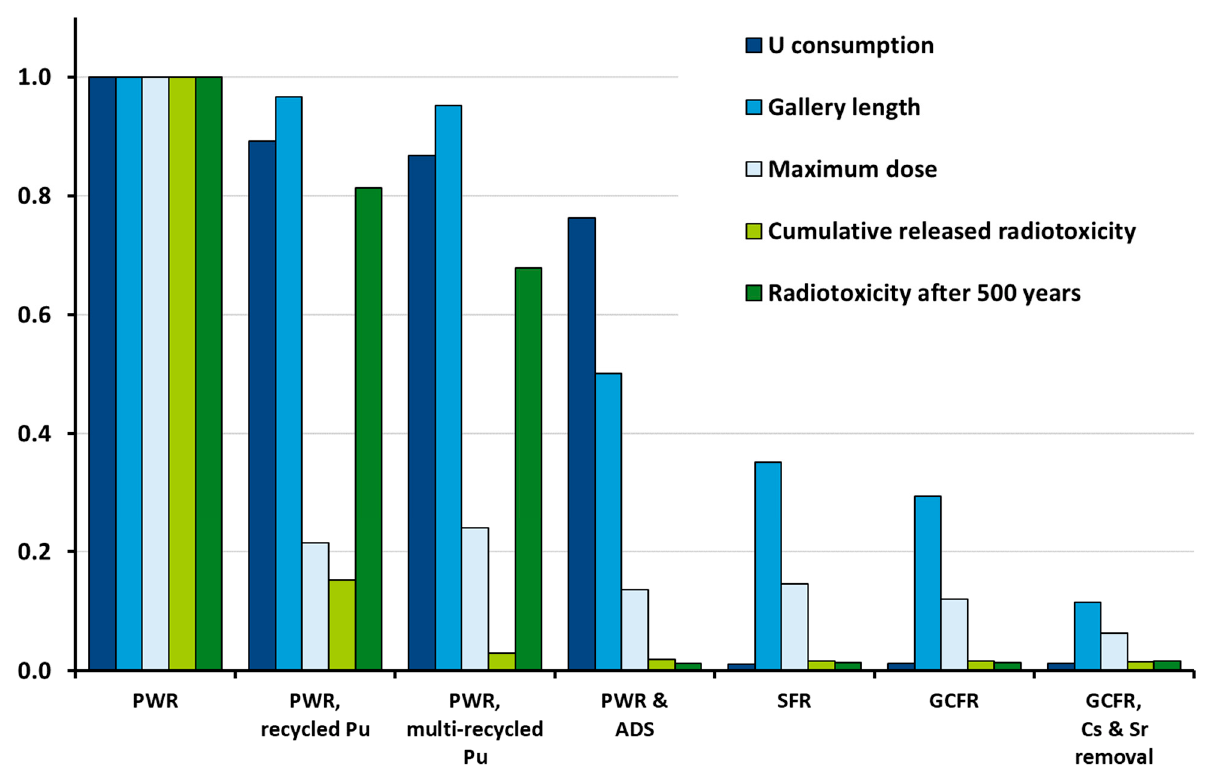
Figure 13. Comparison of fuel cycles with differing degrees of recycling relative to the OTC (redrawn from [28] based on data from RED ‐ IMPACT).